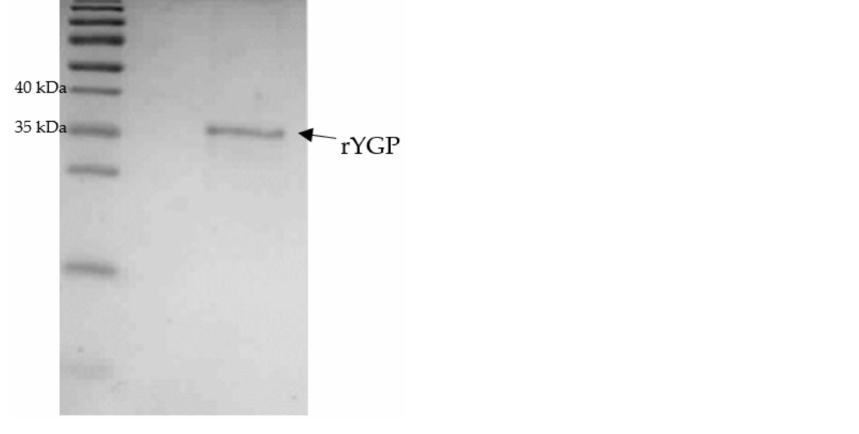
Figure 4. Electrophoretic analysis of rYGP40 after purification and 10 × concentration on Amicon: